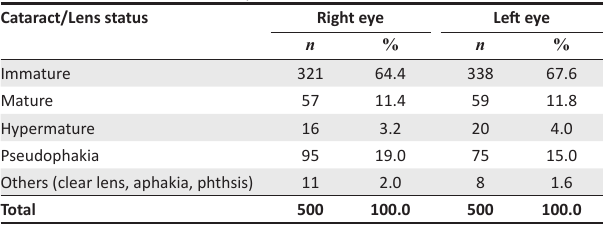
TABLE 1: Cataract/lens status of